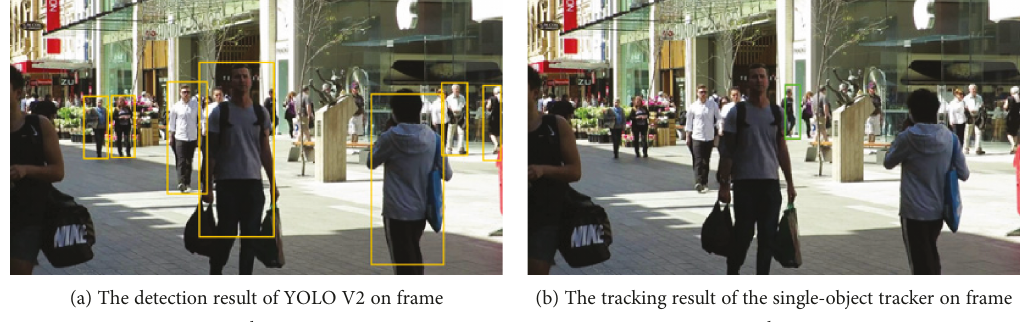
Figure 16: The results of the detection and single-object tracker on